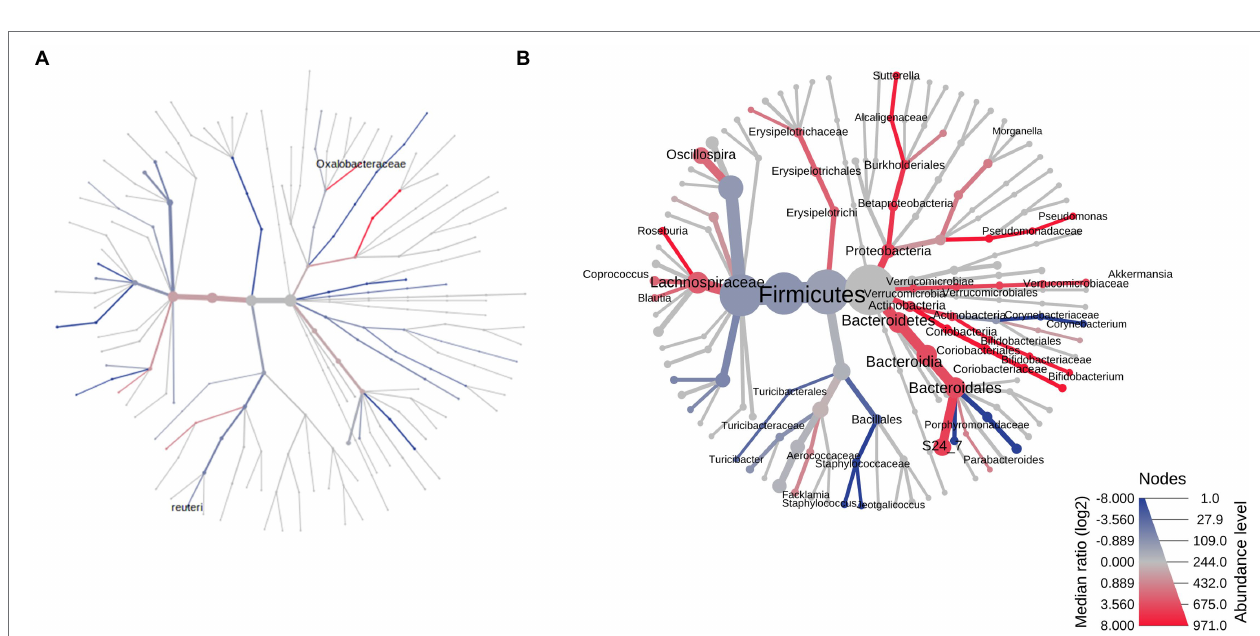
FIGURE 6 | Heat trees of the small bowel microbiomes of male vs. female rats on PAbxD13. (A) Control males vs. control females. (B) Exposed males vs. exposed females. Taxa with lower RA in males vs. females are shown in red. Taxa with higher RA in males vs. females are shown in blue. Nodes represent taxonomic levels, and greater line thickness denotes higher